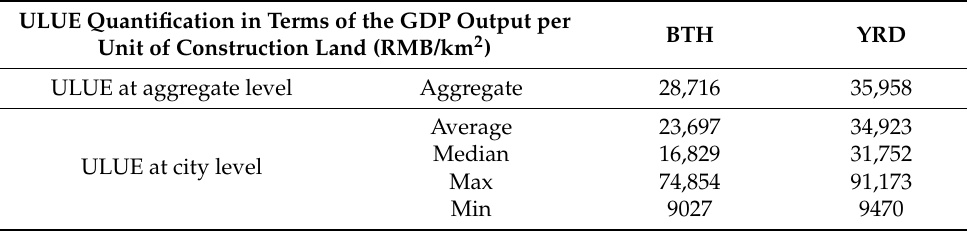
Table 2. Urban land use efficiency (ULUE) values obtained for the GDP output per unit of construction land in the BTH and YRD urban agglomerations.